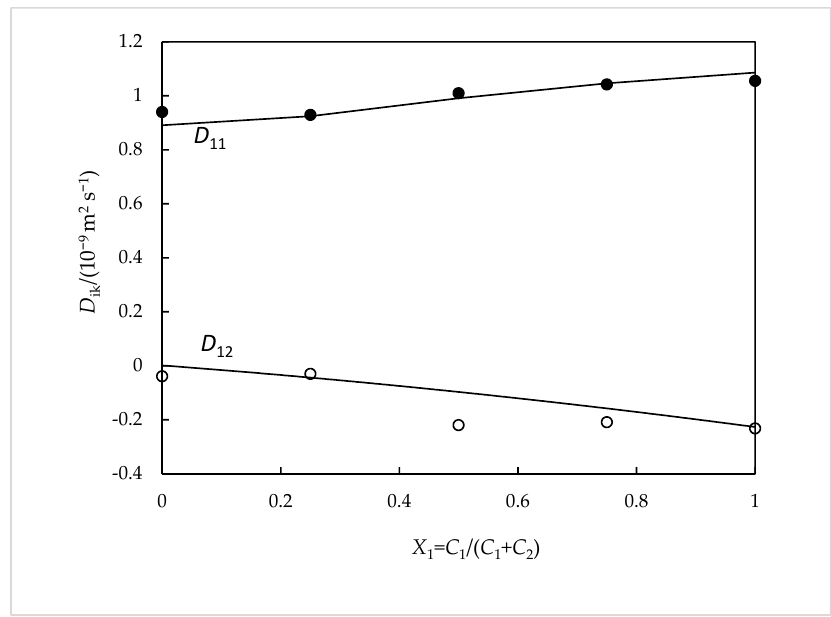
Figure 3. Ternary D ik coefficients for NaSal( C 1 ) + β -CD ( C 2 ) aqueous solutions containing 0.010 mol dm − 3 of total solute compared with the corresponding values calculated from Nernst equations: D 11 , filled circles; D 1 2 , hollow circles. The solid curves correspond to the values calculated from the Nernst equations [3,6].